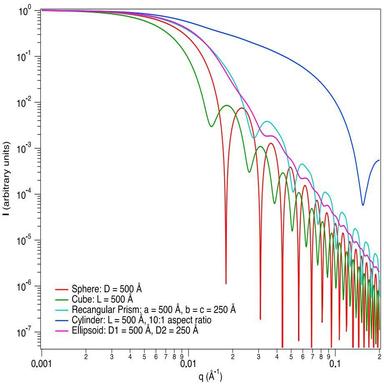
Intensity vs. scattering vector curves calculated using eqs. 5,7–9 for different shapes. Data is normalised to I = 1 at low q to allow comparison of the shapes of the form factors. Data assumes X-ray scattering (λ = 1.54 Å) from monodisperse silica particles ( SLD = 22.7 × 10− 6 ˚A − 1) ) in water ( SLD = 9.47 × 10− 6 ˚A − 1) . The longest dimension is 500 Å for each shape but yield dramatically different scattering curves. Data generated using SASView using scale = 1, background = 0.